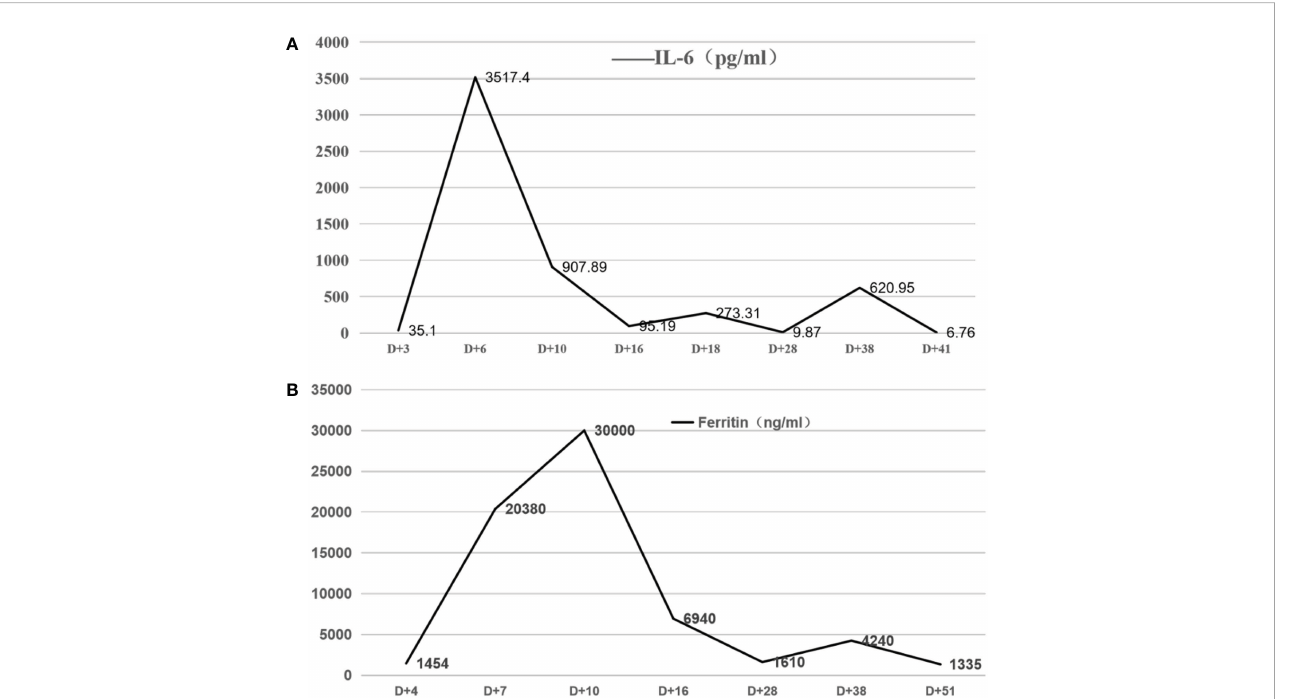
FIGURE 3 (A, B) The serum IL-6 and ferritin levels at different time points after CAR-T cell infusion After CAR T-cell infusion, the patient developed fever and elevation of IL-6 and ferritin levels on d+5. The IL-6 level peaked for the fi rst time on d+6, while the ferritin level peaked for the fi rst time on d+10. The levels of IL-6 and ferritin signi fi cantly increased again on